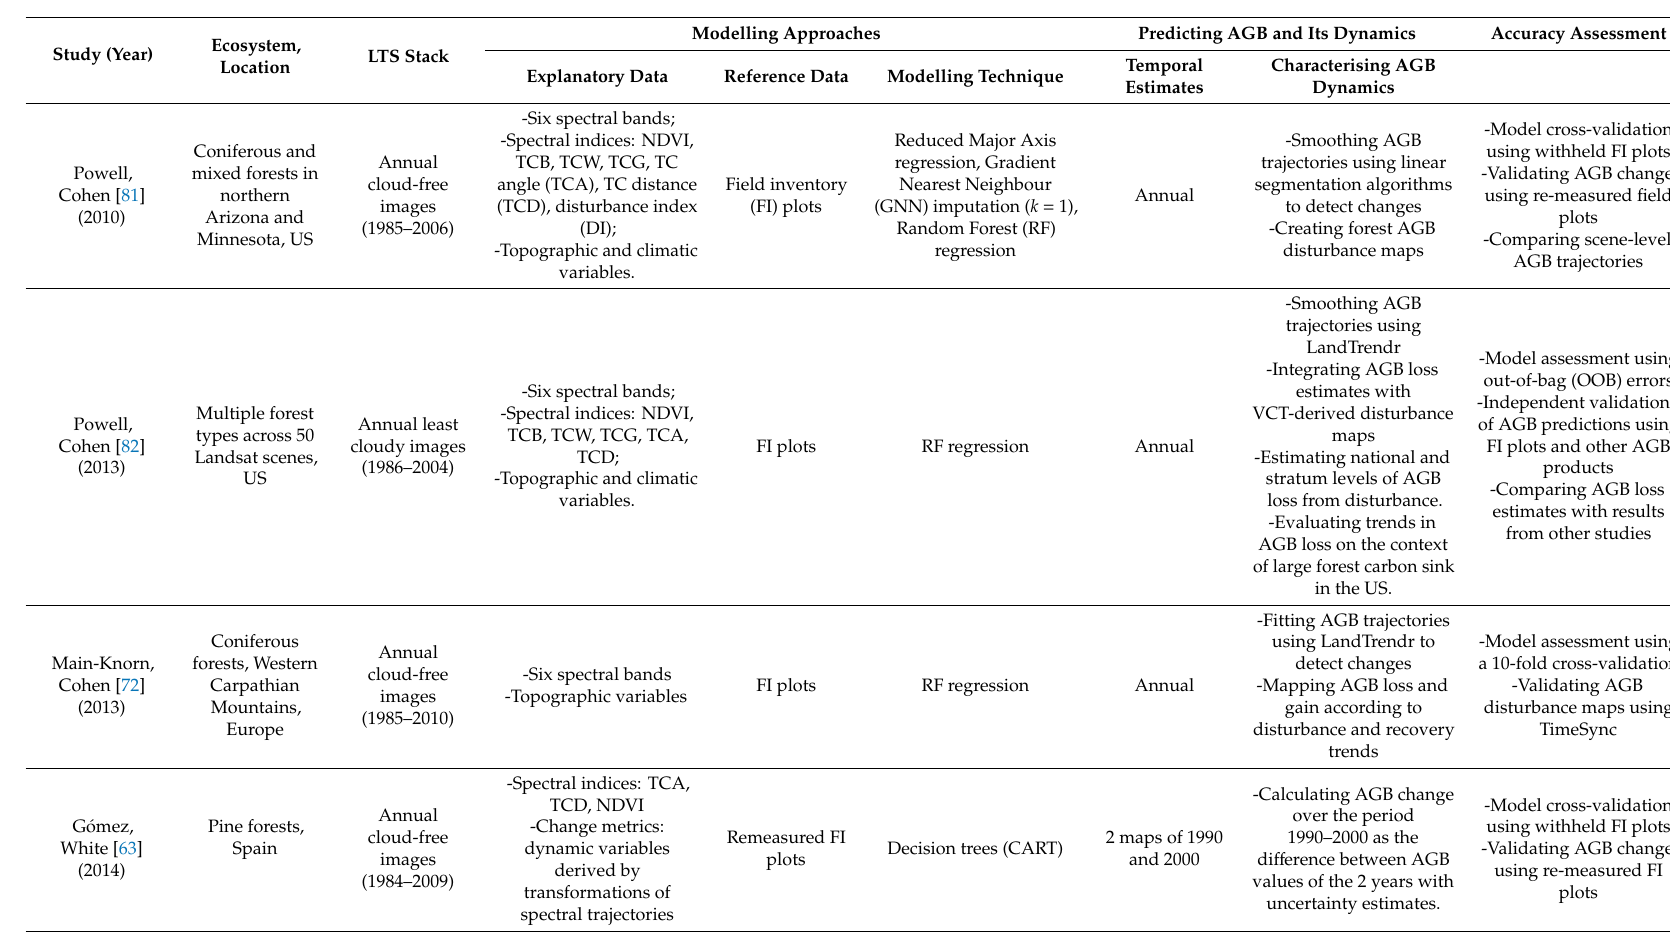
Table 3. A summary of studies that used LTS-based approaches for estimating forest AGB dynamics. See Table A1 for a description of spectral